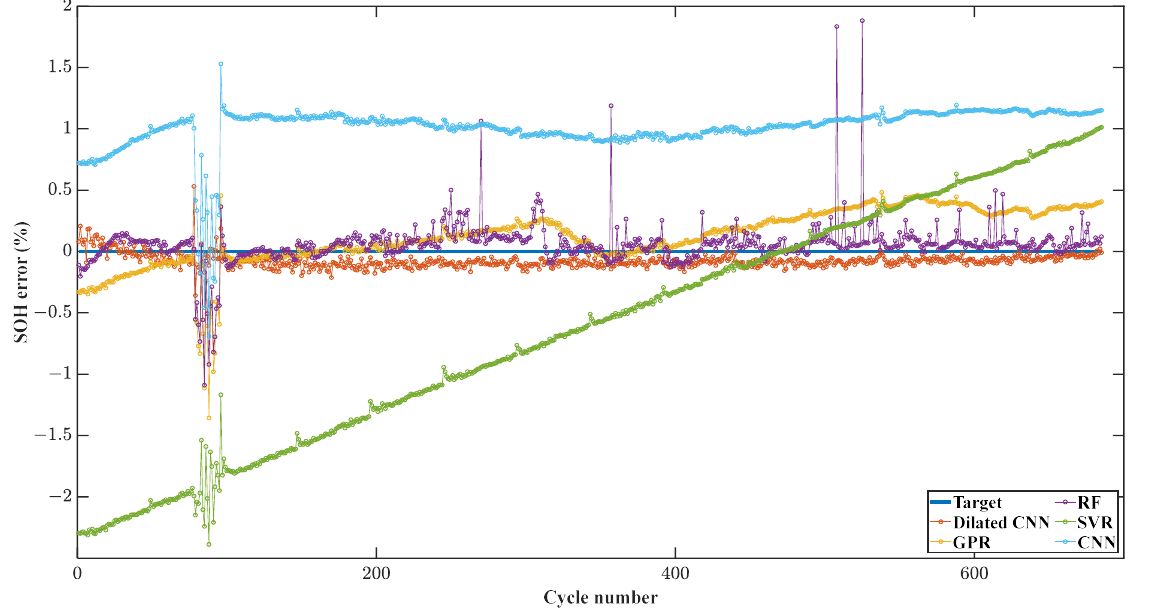
Figure 10. The prediction error diagram of the experiment, with cell 02 as the test